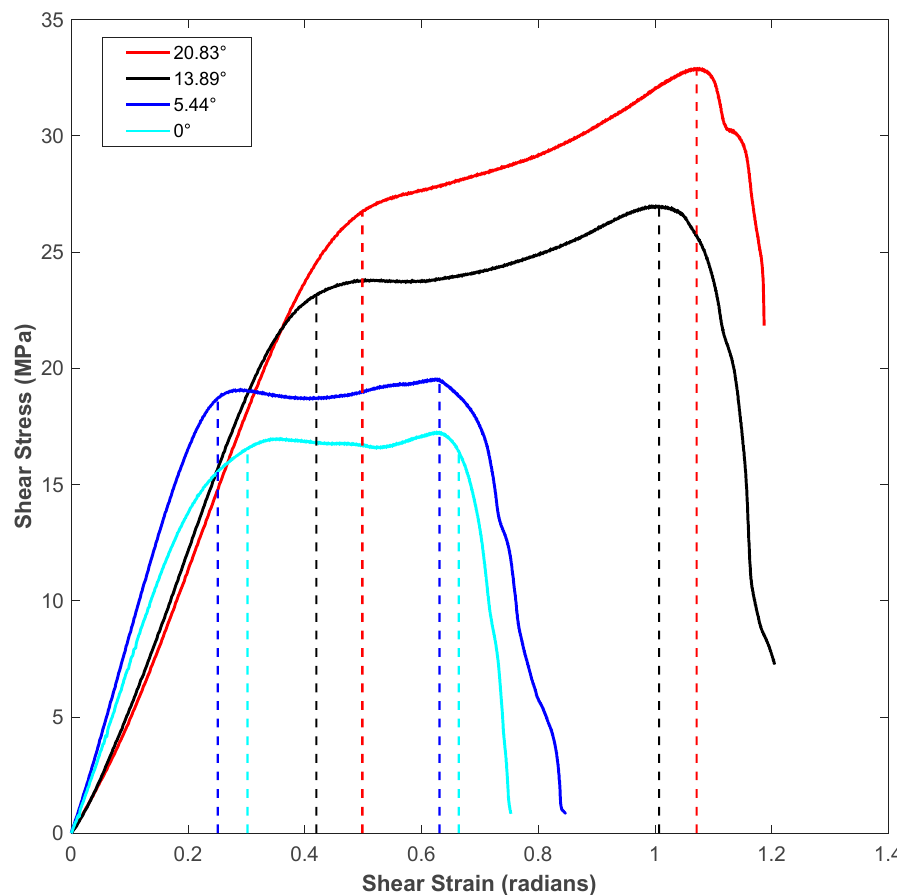
Figure 11. Shear stress-strain response of the 0/90 ◦ raster orientation with all four notch angle configurations.